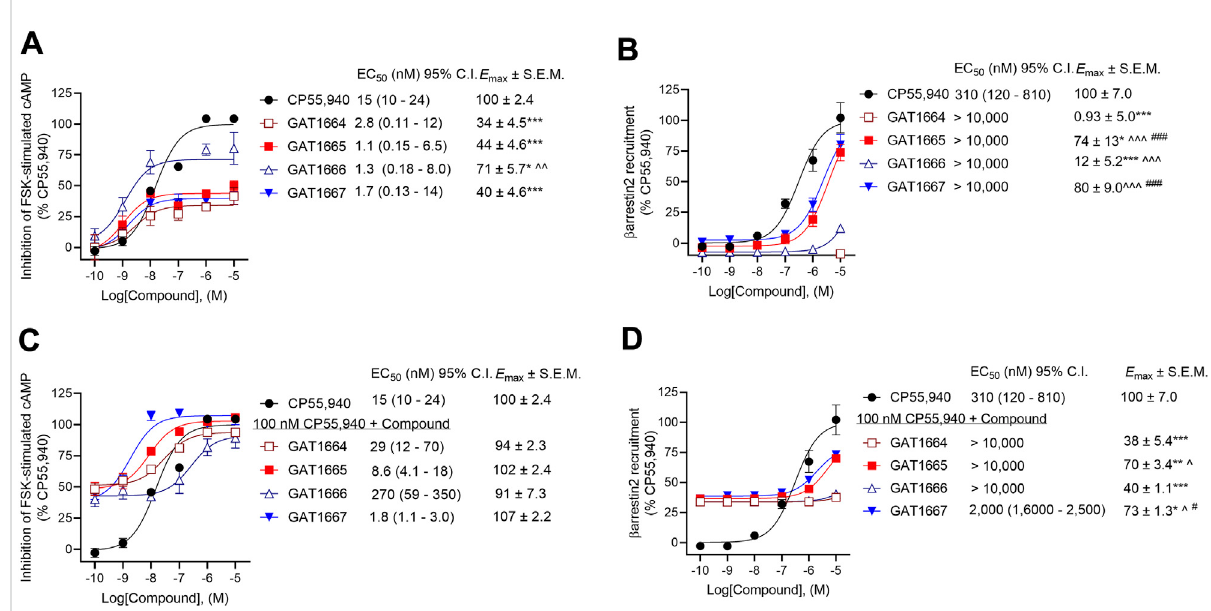
FIGURE 3 Assessment of GAT1664, GAT1665. GAT1666, and GAT1667 signaling. hCB1R CHO-K1 were treated with 0.10 nM – 10 µM GAT compounds ±100 nM CP55,940. (A) cAMP inhibition of GAT compounds as agonists, (B) β arrestin2 recruitment of GAT compounds as agonists, (C) cAMPinhibitionofGATcompoundsasPAMsinthepresenceof100 nM CP55,940,and (D) β arrestin2recruitmentofGATcompoundsasPAMsinthe presence of 100 nM CP55,940. cAMP inhibition and β arrestin2 recruitment data are expressed as % CP55,940 max. Data were fi t to a nonlinear regression (3-parameter model, GraphPad v. 9.0) to determine EC 50 and E max . Data are mean ± SEM ( E max ) or 95% CI (EC 50 ); n = 4 independent experiments performed in triplicate, except for CP55,940 where n = 12 independent experiments performed in triplicate as this compound